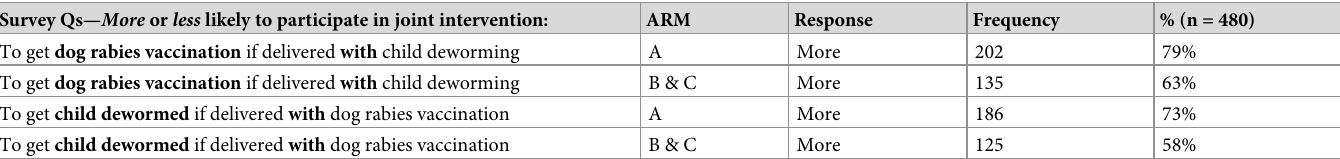
Table 5. Likelihood of participating in an integrated health delivery programme. The survey questions and the Arm specific responses are given. Arm A received both dog vaccination and deworming for children. Arm B received deworming for children only and Arm C received dog vaccination only. S1 Data. Survey Qs— More or less likely to participate in joint